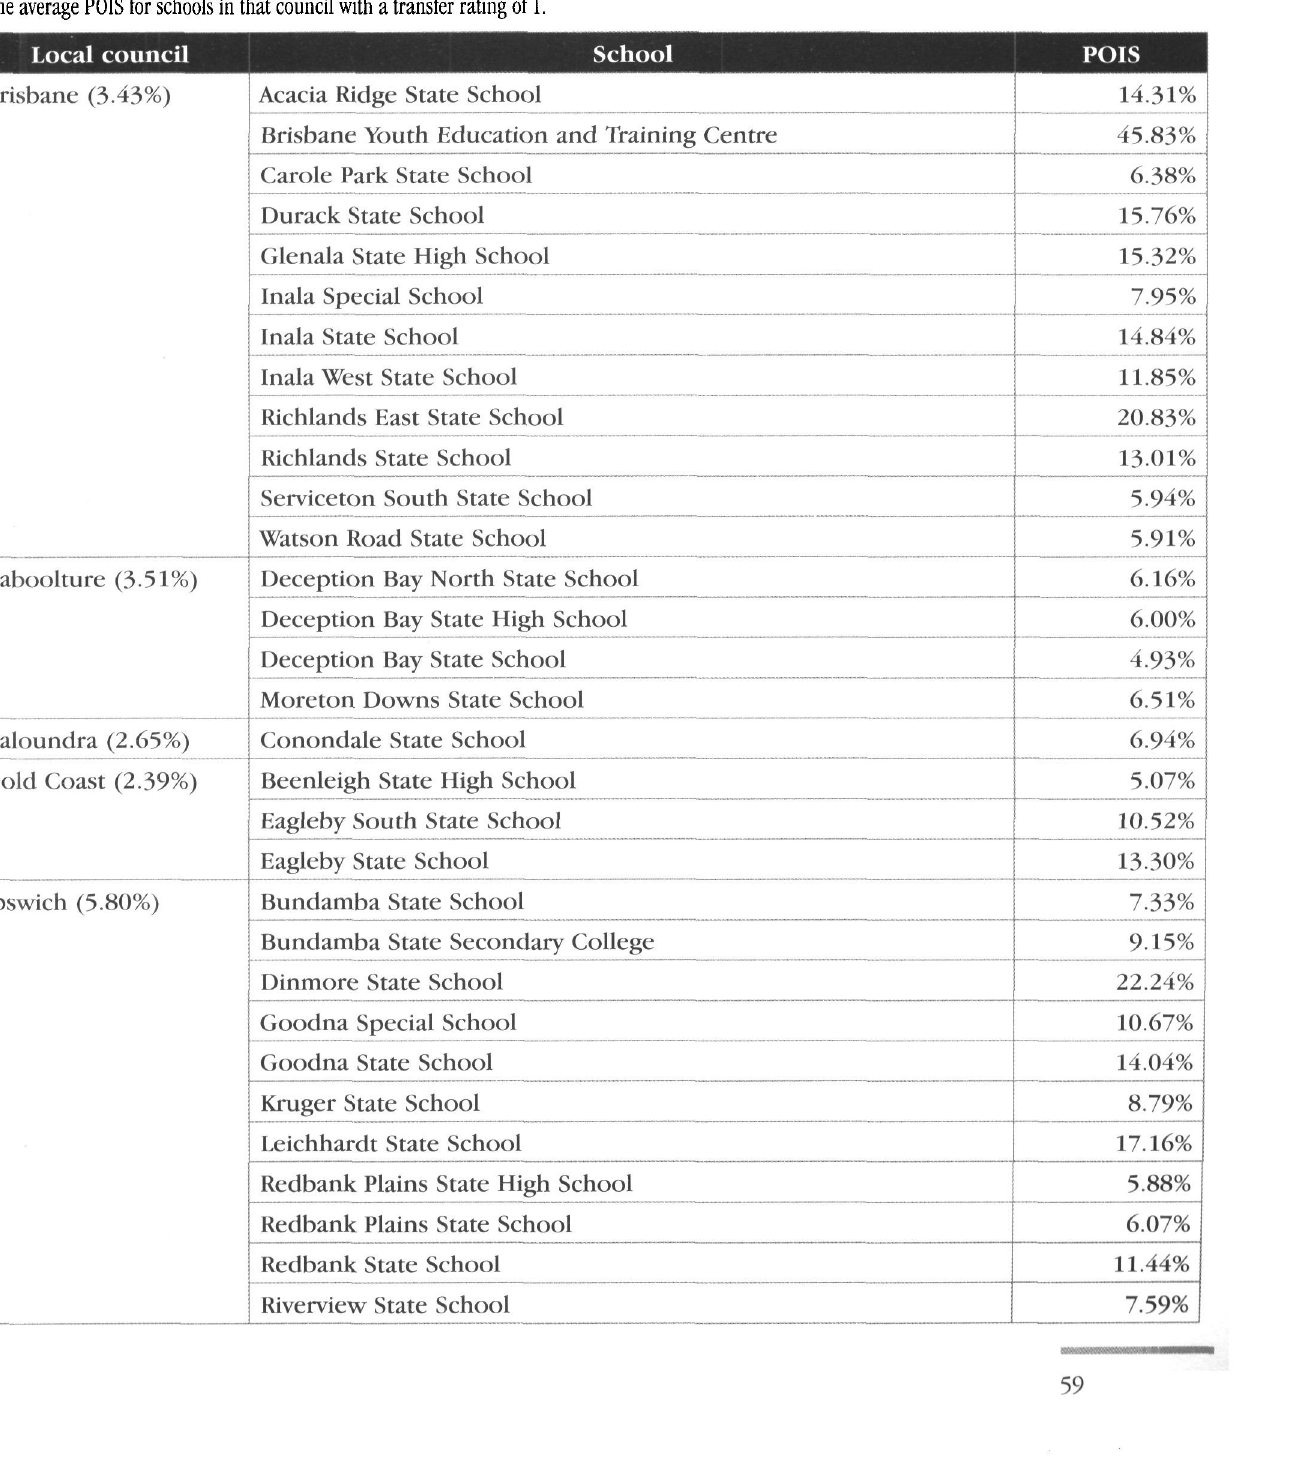
Table 7. Southeast Queensland schools with a transfer rating of 2 and a higher-than-average POIS. The percentage in brackets following each local council is the average POIS for schools in that council with a transfer rating of